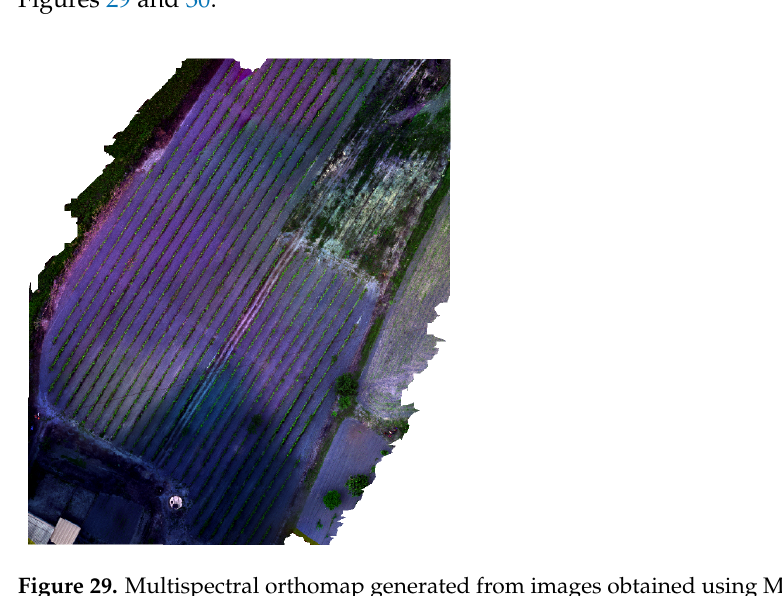
Figure 29. Multispectral orthomap generated from images obtained using MicaSense camera. Dis- tance between two points is approximately 0.2